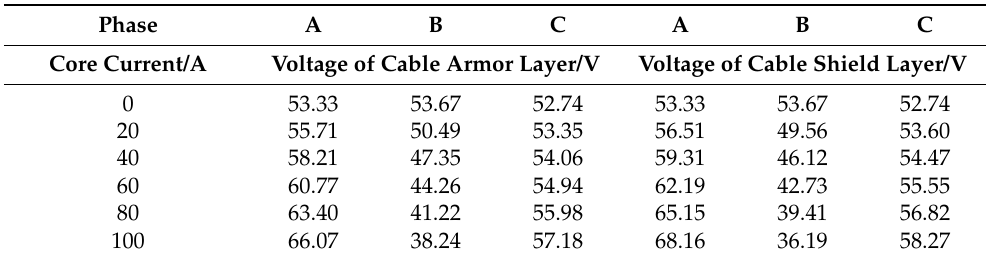
Table 6. Simulation value of induced voltage of metal sheath with a separate sheath protector when there is a single vehicle.